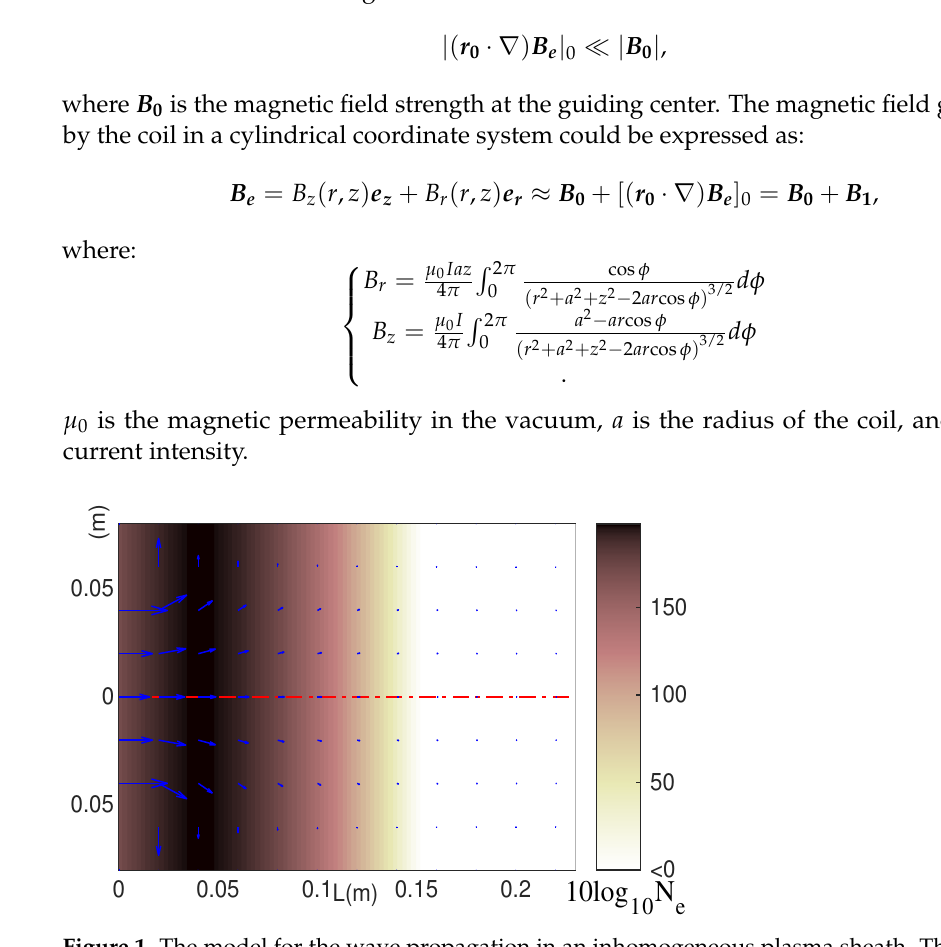
Figure 1. The model for the wave propagation in an inhomogeneous plasma sheath. The external magnetic field is generated by a